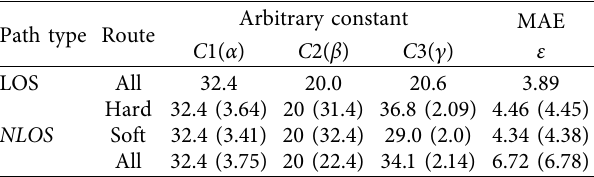
Table 4: Summary of the CI and ABG arbitrary constants of dual